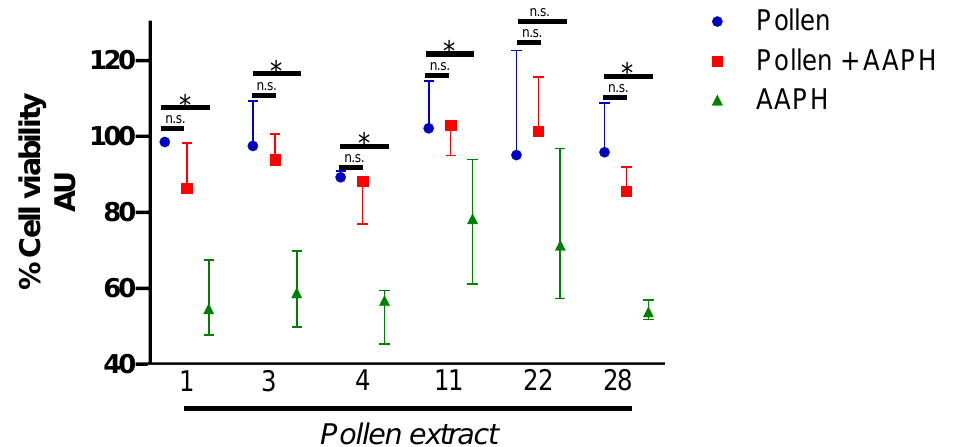
Figure 2. Pollen extract prevents 2,2′-Azobis(2-amidinopropane) dihydrochloride (AAPH) induced cell death. Cell viability evaluated by Alamar blue of Hepa1-6 cells treated with ethanol extracts of pollen 1, 3, 4, 11, 22, and 28 at a concentration of 0.1 mg/mL and co-treatment with AAPH for 24 h at 0.2 mm. Cell viability expressed as a percentage of viable cells relative to cells treated only with pollen extract. Data are shown as median ± first quartile and third quartile ( n = 3). Mann-Whitney statistical test was performed between the cells treated with pollen, pollen + AAPH, and AAPH. The asterisks (*) represent statistically significant differences ( p < 0.05). n.s.: not significant.